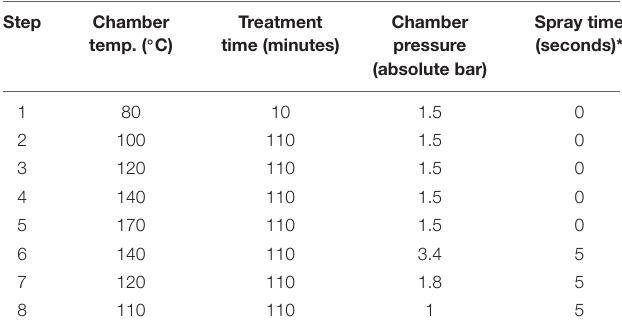
TABLE 1 | Treatment conditions for the thermal modification process used for western hemlock in this study derived from Song et al. (2019).